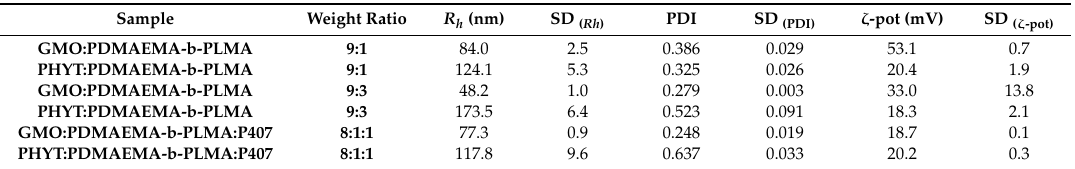
Table 2. The physicochemical characteristics of the prepared nanosystems in HPLC grade water, on preparation day (t = 0